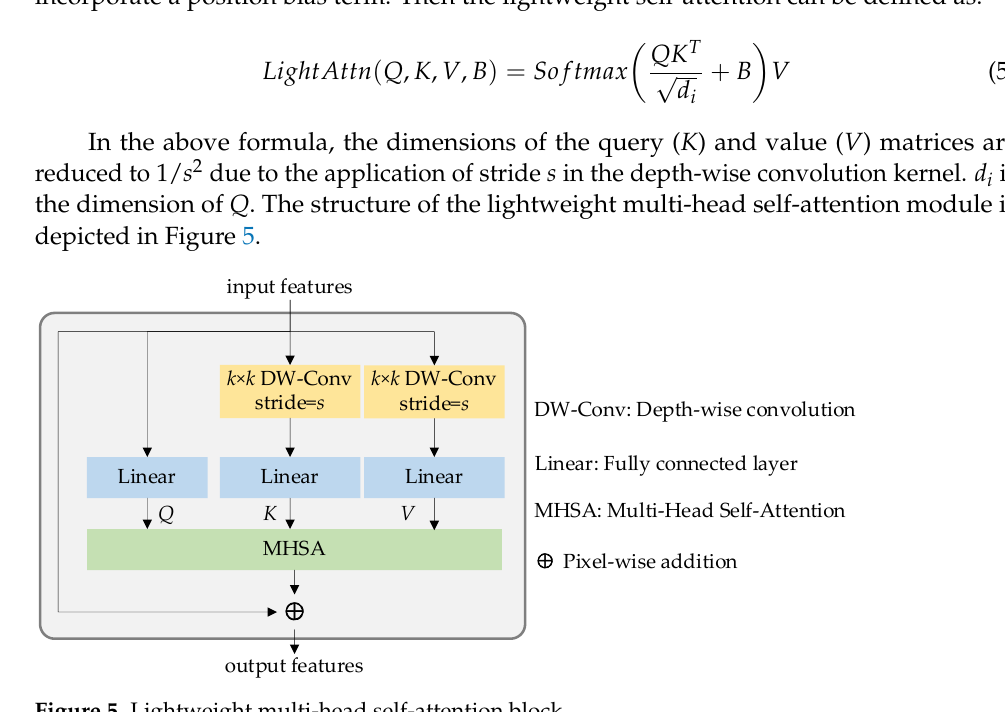
Figure 5. Lightweight multi-head self-attention block.